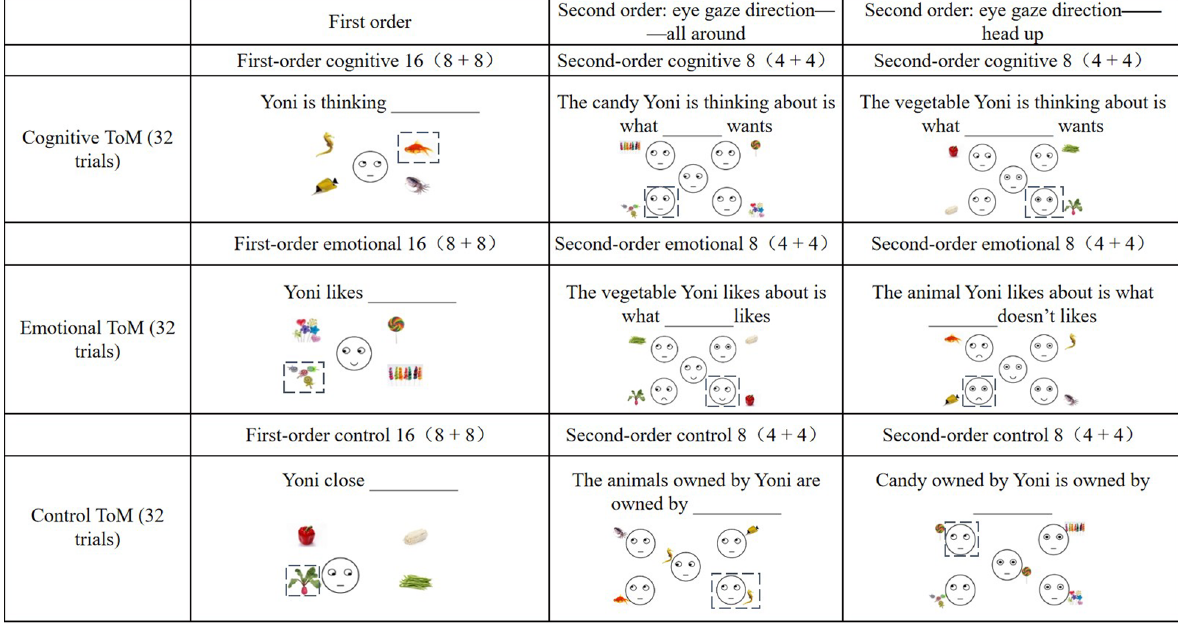
Fig. 4 Trials and examples of different task conditions in the Yoni task. Note. Only an example of the exercise task is shown in the figure, in the formal experiment, the face pictures of cartoon characters were replaced with Uygur and Han face pictures of the same gender as the subjects. For the convenience of reading, we have dotted the correct